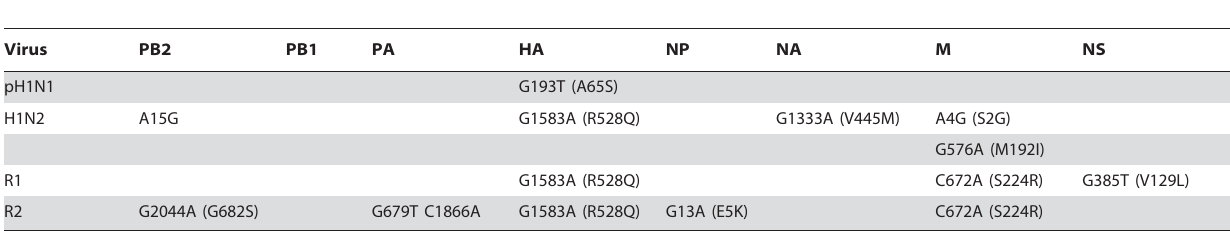
Table 2. Single nucleotide polymorphisms identified in pH1N1 and H1N2 following 10 passages in ST cells as compared to genome sequences prior to cell passaging a